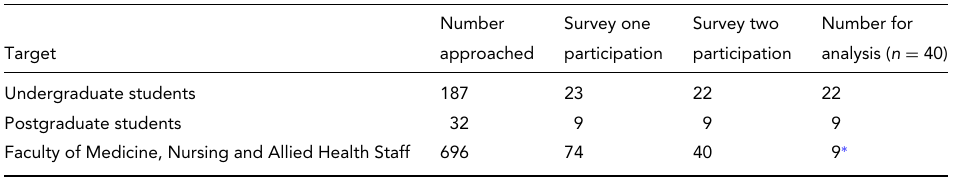
Participant Recruitment Numbers for Survey Participation